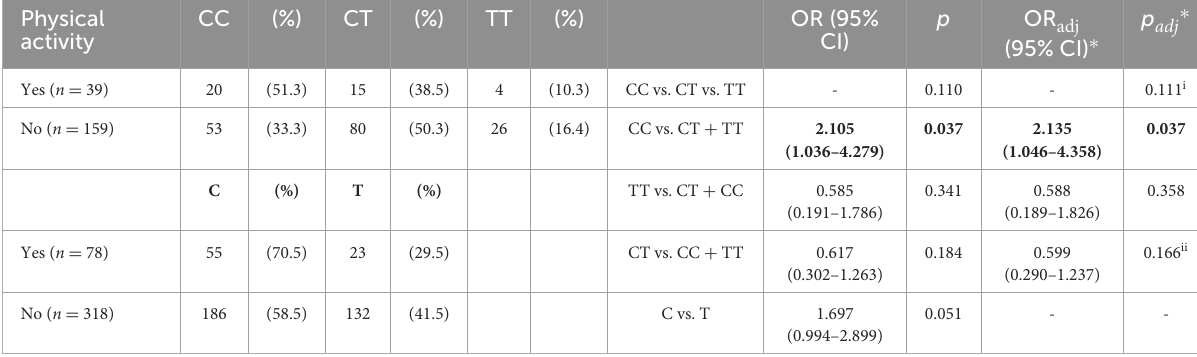
TABLE 10 Association analysis of the UCP2 rs660339 variant with physical activity as migraine trigger.